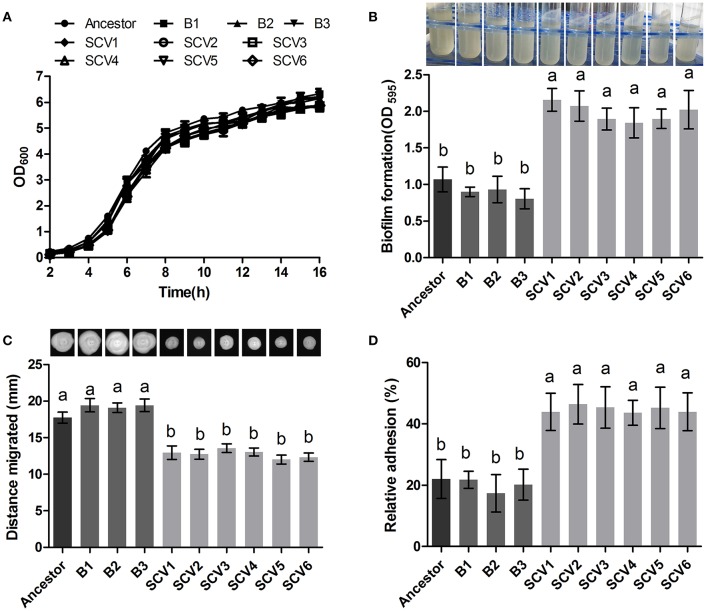
Growth curve, biofilm formation, motility and cell adhesion of the ancestor, B (non-Tetrahymena-exposed) strains and SCV strains (Tetrahymena-exposed). (A) Growth curves of the ancestor, B strains and SCV strains. The strains were grown in LB medium. (B) Biofilm formation was measured with crystal violet staining using 96-well plates, and it was expressed as the values of OD595. The tubes showed that lots of biofilm was formed on the tube wall after SCVs culture overnight with a shaker at 28°C. (C) Swimming ability was observed after culturing at 28°C for 48 h on 0.3% LB agar plates. The swimming distance was measured from inoculation point. (D) The relative adhesion was calculated by dividing the number of colony-forming units (CFU) of adhered bacteria by the number of CFU of the inoculum. Data are presented as the mean ± SD of three independent experiments, with each experiment being consisting of three replicates. Different lowercase letters (a, b) indicate significant differences (P < 0.05) among different bacterial strains.